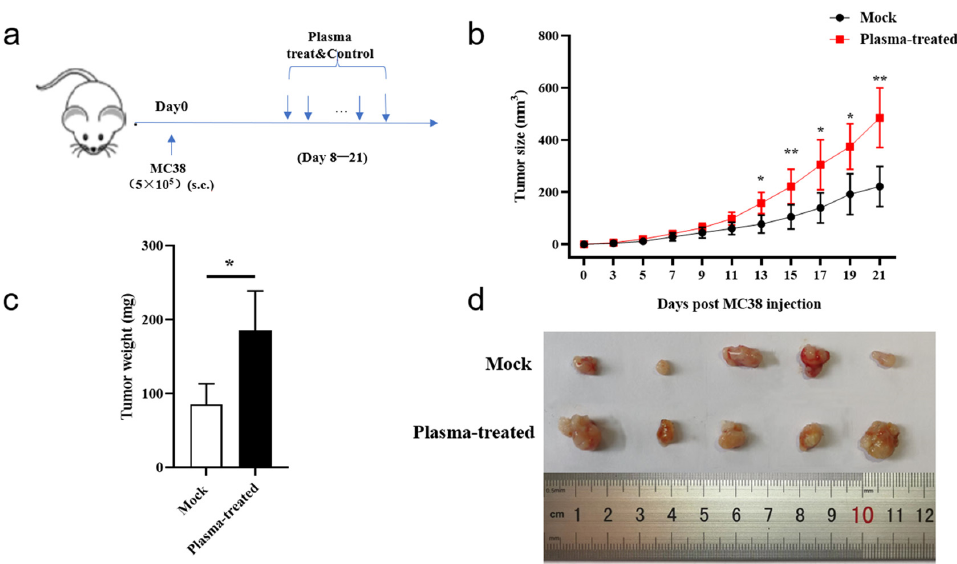
Figure 3. CAP treatment in vivo facilitates tumor growth in mice. ( a ) Schematic diagram depicting the tumor-bearing mice and CAP treatment. The mice are subcutaneously injected with 5 × 10 5 MC38 cells on day 0 and then subjected to CAP treatment from days 8 to 21. ( b ) Growth curves of the subcutaneous tumors in the mock and PT groups, n = 5. ( c ) Weight of subcutaneous tumors in the mock and PT groups, n = 5. ( d ) Images of the tumors on day 21 after implantation of tumor cells. The data are from 15 biologically independent animals (mean ± SD for ( b , c )) and the statistical analysis is performed using two-sided unpaired t -tests (* p < 0.05 and ** p < 0.01).